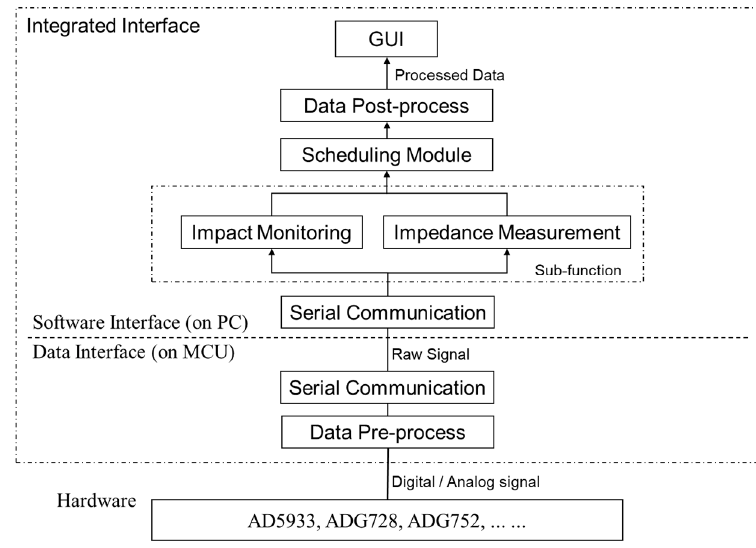
Figure 7. The scheme of the designed integrated interface.